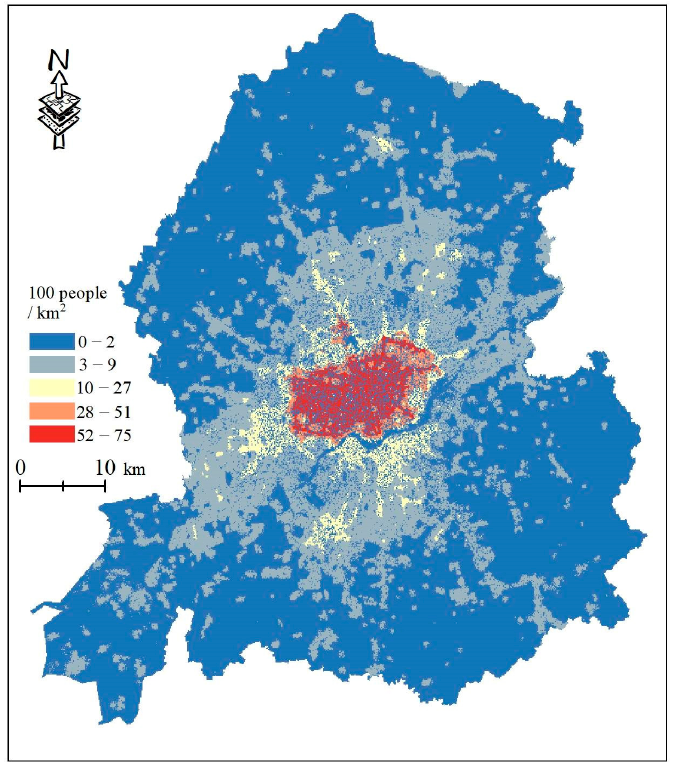
Figure 6. Spatial distribution of vulnerable populations.